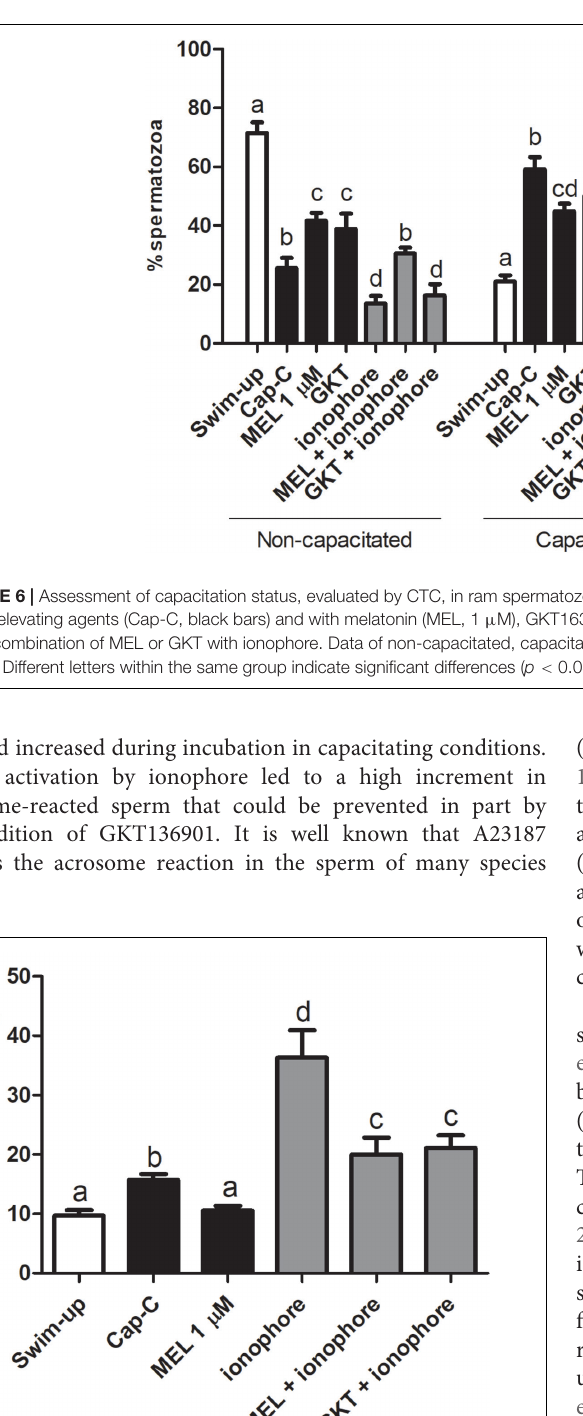
FIGURE 7 | Percentage of live sperm with high superoxide levels (Yo-Pro-1–/E+) assessed by flow cytometry before (swim-up, white bars) and after in vitro capacitation with cAMP-elevating agents (Cap-C, black bars) and with melatonin (MEL) 1 µ M or/and calcium ionophore A23187 (ionophore, gray bars), plus a GKT136901 with ionophore sample (GKT + ionophore). Data are shown as mean ± SEM ( n = 6). Different letters indicate significant differences ( p <